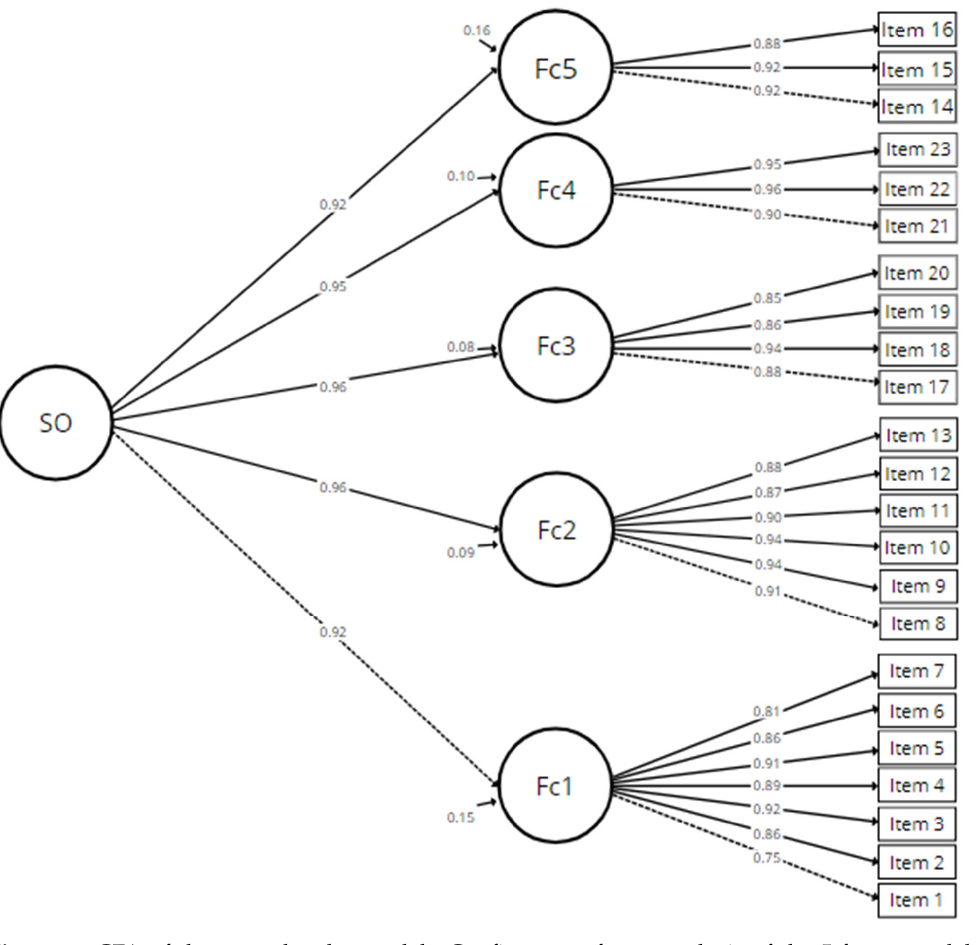
Figure 2. CFA of the second order model. Confirmatory factor analysis of the 5-factor model with a second order factor, SO (Second Order Factor) = Quarantine coping strategies; Fc1 (Factor 1) = Emotional regulation; Fc2 (Factor 2) = Information; Fc3 (Factor 3) = Social support; Fc4 (Factor 4) = Altruism; Fc5 (Factor 5) = Accommodation.